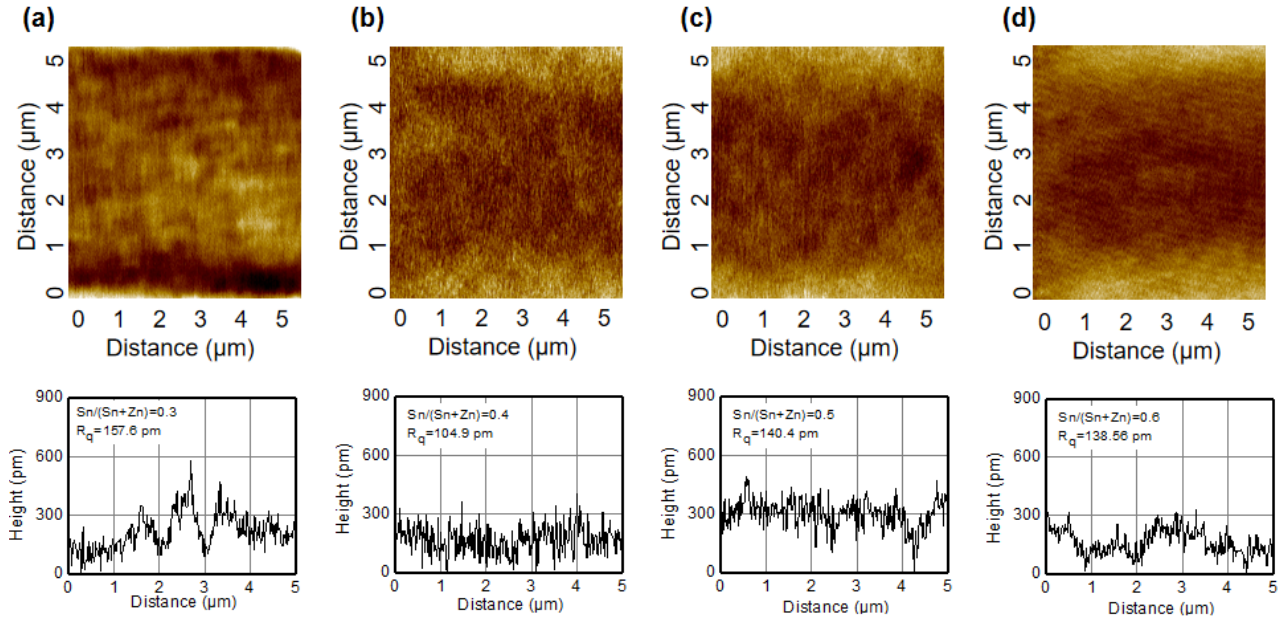
Figure 3. AFM images of ZTO semiconductor surface with Sn/(Sn+Zn) ratios of ( a ) 0.3, ( b ) 0.4, ( c ) 0.5, and ( d ) 0.6.